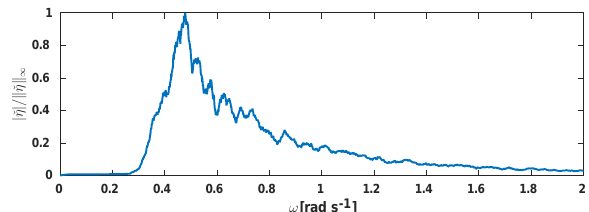
Figure 16. The same as Fig. 7; now for the case